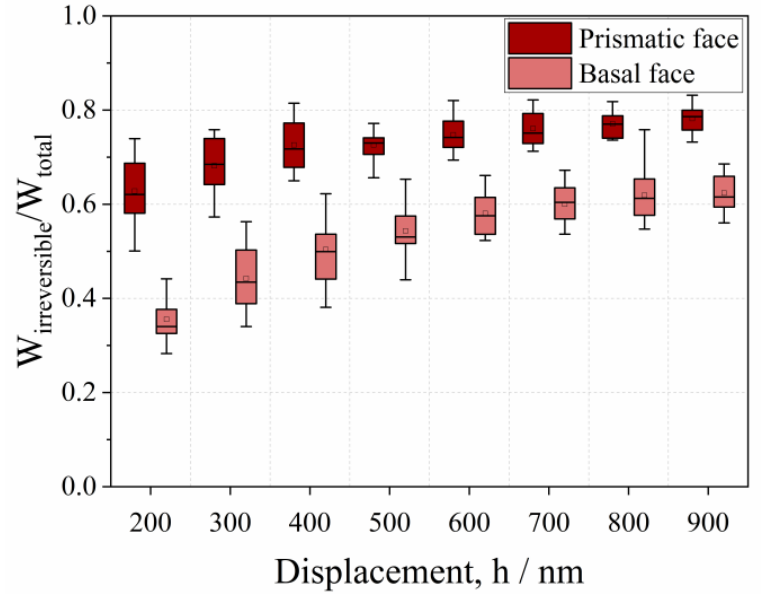
Figure 8. Fraction of irreversible deformation on the prismatic and basal crystal faces at penetration depths from 200 to 900 nm.